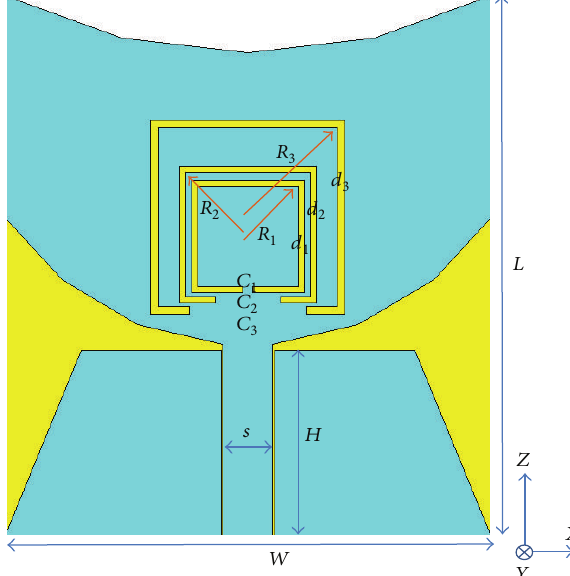
Figure 1: Geometry of antenna, with dimensions 𝑅 1 = 3.75 mm, = 4.61 mm, 𝑅 = 6.6 mm, 𝐶 = 0.5 mm, 𝐶 = 3.35 mm, 𝐶 𝑅 2 3 1 2 = 0.3 mm, 𝑑 = 0.3 mm, 𝑑 = 0.4 mm, 𝑠 = 2.5 mm, 𝐻 = 6 mm, 𝑑 1 2 3 9.8 mm, 𝑊 = 25 mm, and 𝐿 = 27.9